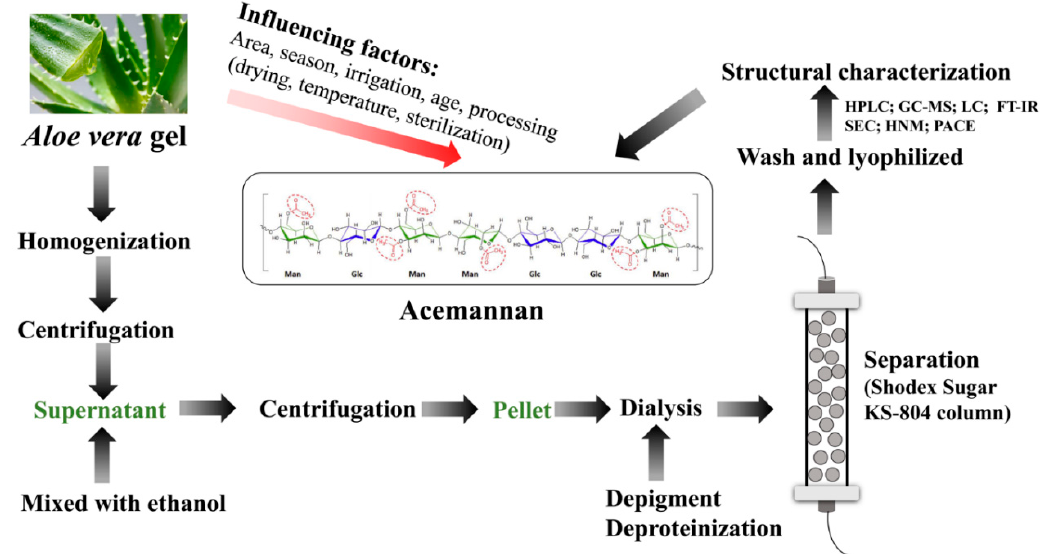
Figure 1. Schematic representation of extraction, separation purification and structure characterization of acemannan from Aloe vera .